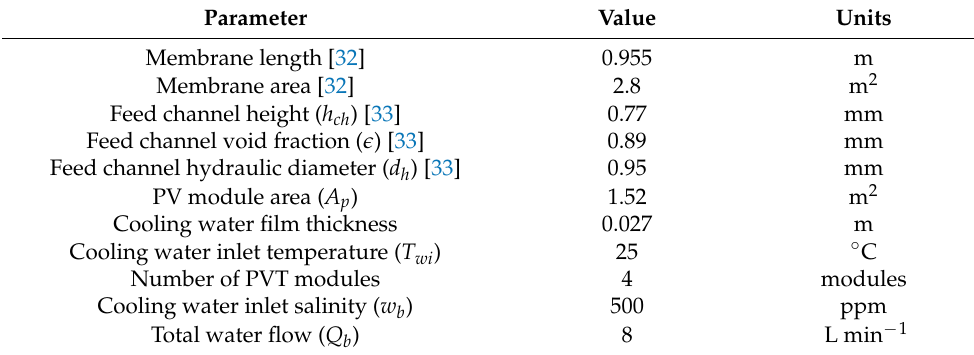
Table 3. Simulated PVT-RO unit dimensions and characteristics.